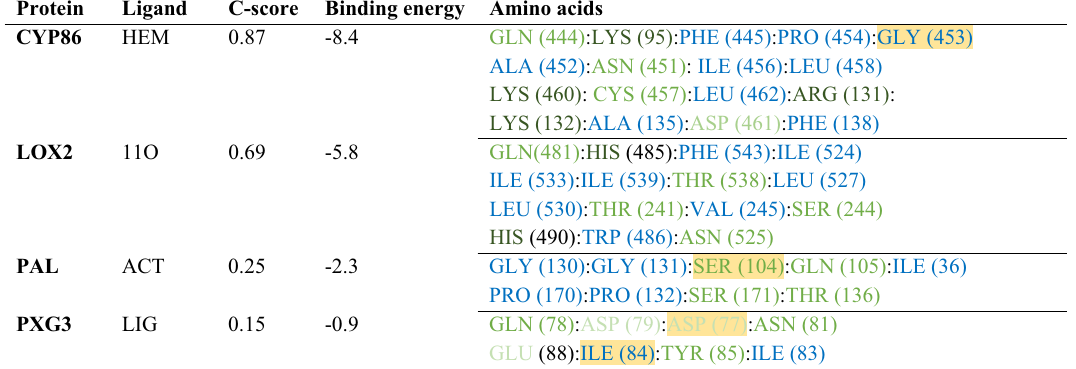
Table 6. Ligand and protein interacting amino acids in 5A and their characteristics. Polar amino acids: green, non-polar amino acids: blue, positively charged amino acids: dark green, negatively charged amino acid: light green, hydrogen bond: yellow highlight.